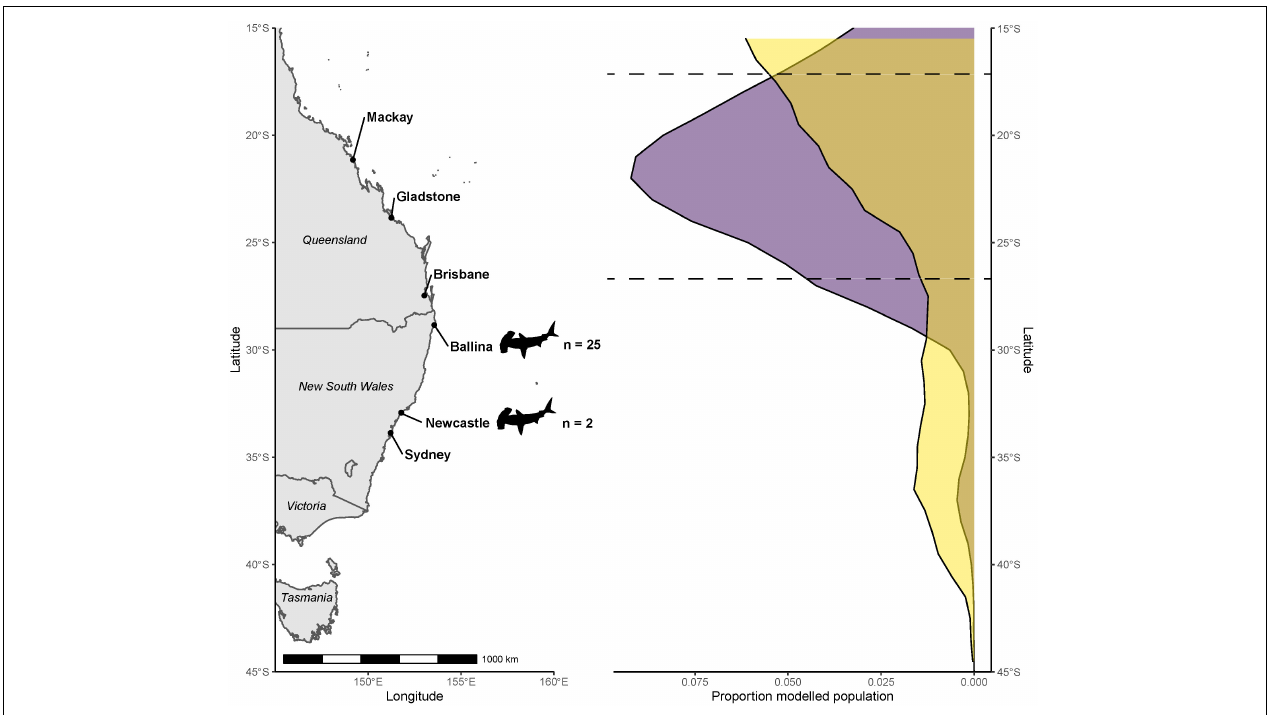
FIGURE 3 | Modeled population geographic range of coastal great hammerhead sharks ( Sphyrna mokarran ) inferred from δ 13 C stable isotope values of their muscle tissues, and those from the various marine fish species, used to produce a latitude - δ 13 C fish value relationship (purple). Corresponding modeled population density from the mechanistic NEMO-MEDUSA data shown for comparison (yellow). Dashed lines indicate latitudes that contained nearly 80% of the modeled population from the sample-driven model. Locations where great hammerhead shark samples were collected are indicated by shark